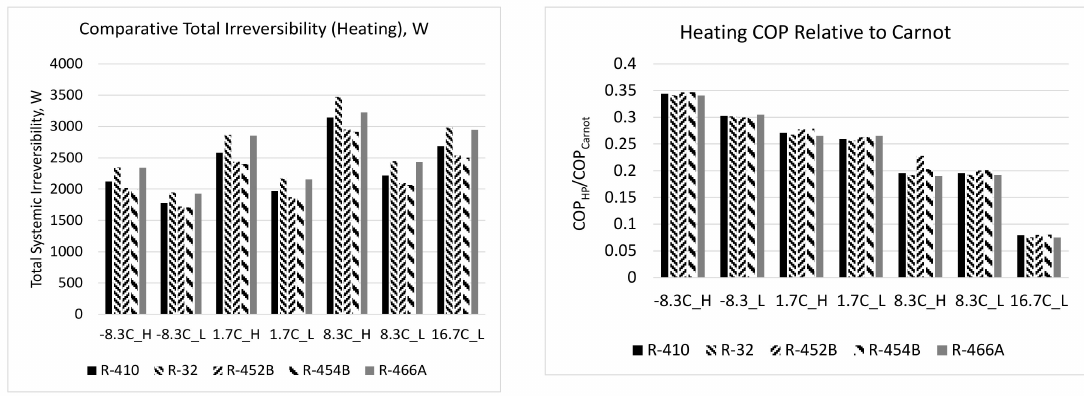
Figure 8. Performance of refrigerants in the HP ( left ) at various AHRI 210 / 240 standard rated conditions, and ( right ) as compared with the Carnot e ffi ciency at the same rated